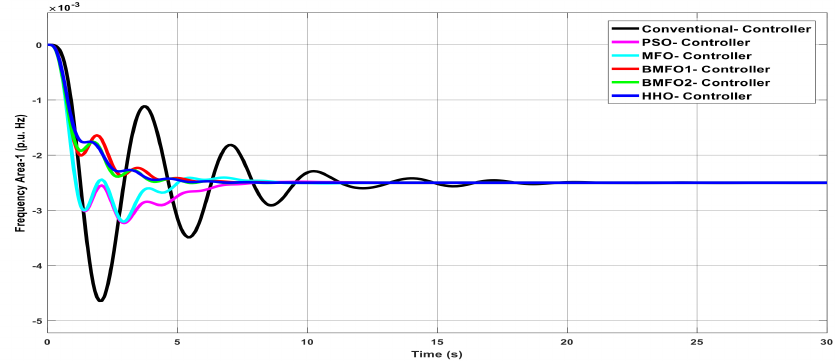
Figure 15. Dynamic response of Area1 frequency with various controllers under contract violation